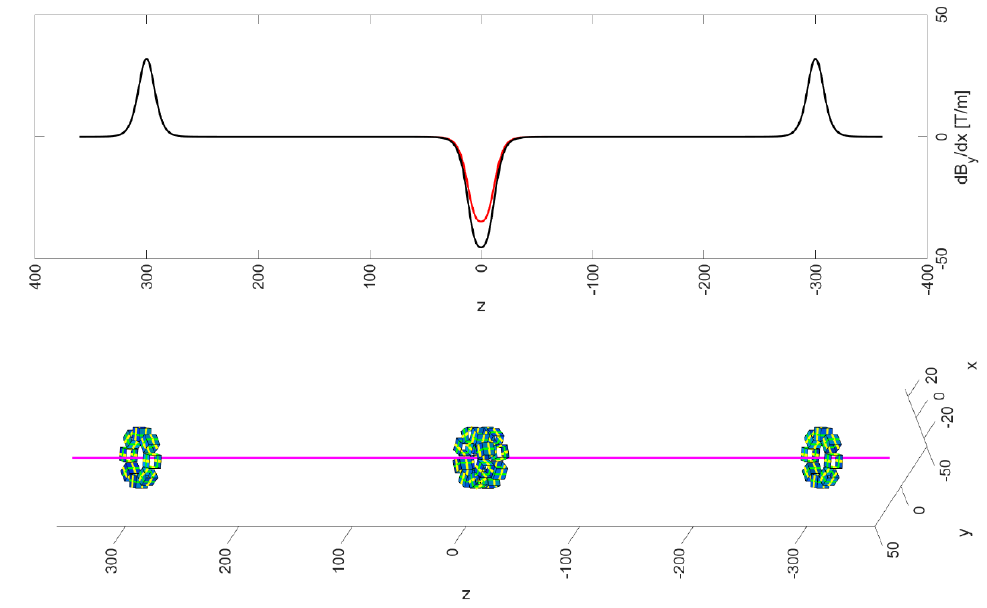
Figure 10. Bottom: four quadrupole rings assembled to form a triplet. The strength of the double- ring is adjustable as described in Section 7. Top: the gradient along the beam line for rotation angles of the central quadrupoles of ψ = 0 ◦ (black) and ψ = 20 ◦